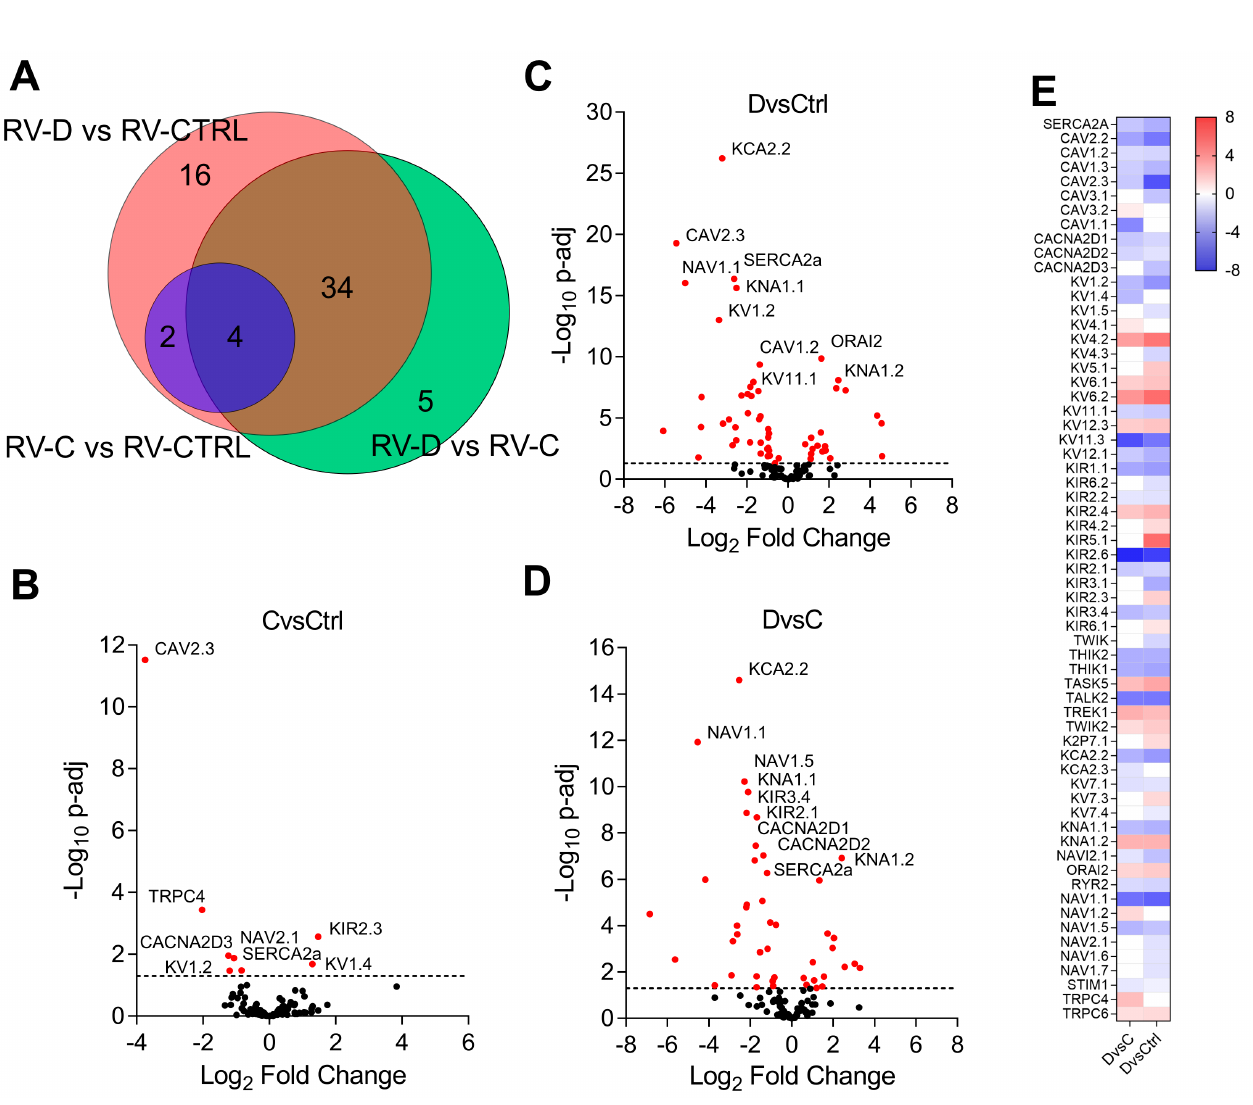
Figure 1. Channel gene expression profile analysis of PAH patients with compensated (RV-C) or decompensated RV (RV-D) compared to healthy donor RV (RV-CTRL). ( A ) Venn diagram of overlapping DEGs from RV-D, RV-C, and RV-CTRL patients. ( B – D ) Volcano plot of DEGs from RV-C versus RV-CTRL, RV-D versus RV-CTRL, and RV-D versus RV-C. The horizontal dash line represents False Discovery Rate-corrected p -value cutoff <0.05. Red points represent statistically significant DEGs. ( E ) Heat map of statistically significant DEGs from the following groups: RV-D versus RV-CTRL; RV-D versus RV-C. Blue or red represents downregulation or upregulation,